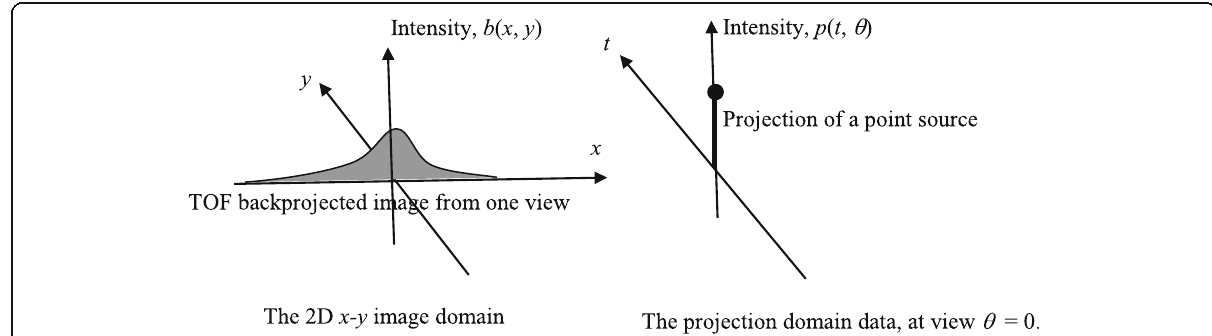
Fig. 1 Projection of a point source at the origin (shown on the right) and the associated time-of-flight (TOF) backprojection (shown on the left). The TOF backprojection of a single event uses a profile function along the